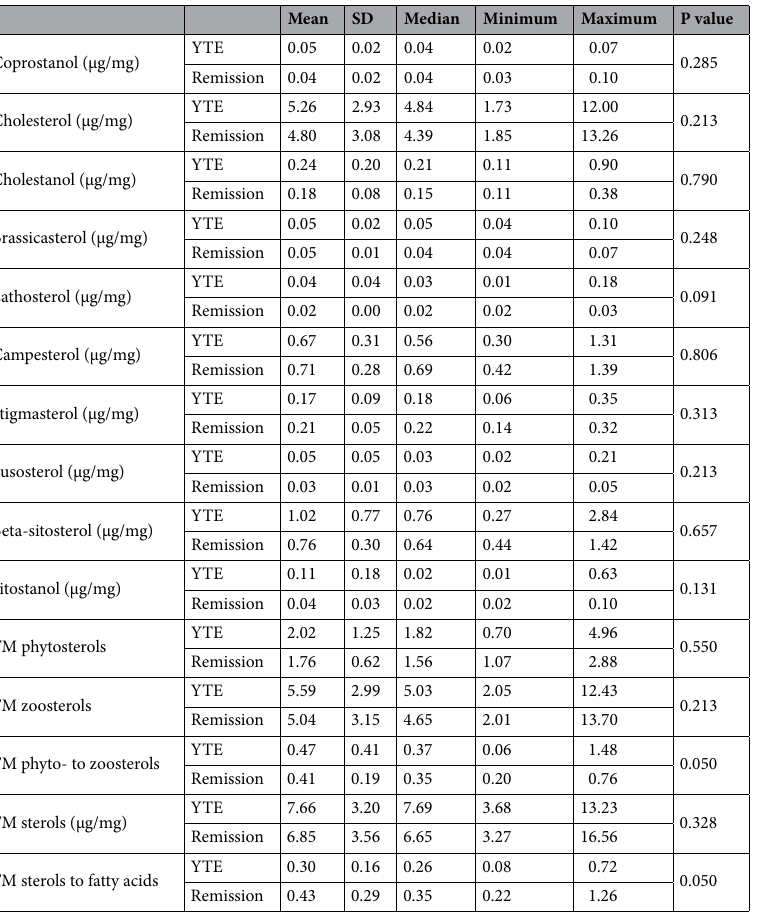
Table 7. Summary statistics of fecal sterol concentrations in YTE dogs before and after treatment. TM, total measured; TM Phyto- to Zoosterols; ratio of total measured phyto- to total measured zoosterols; TM Sterols to Fatty Acids; ratio of total measured sterols to total measured fatty acids; YTE, Yorkshire Terrier enteropathy; SD, standard